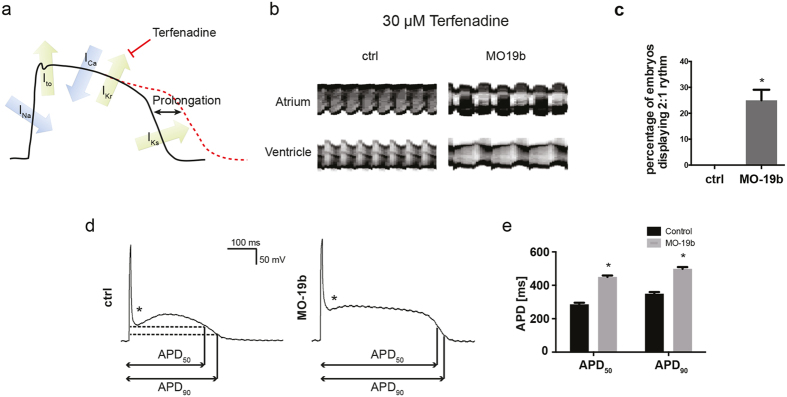
Loss of miR-19b induces prolongation of the action potential.(a) Schematic illustration of an action potential with major depolarizing and repolarizing currents depicted. Terfenadine inhibits IKr current, thereby prolonging the ventricular action potential. (b) Atrial and ventricular m-mode recorded from control and MO19b-injected Tg(Myl7:GFP) zebrafish embryos after 30 μM Terfenadine treatment. (b,c) 25% ± 4.1% of miR-19b deficient embryos develop an AV-Block with the ventricle skipping every other contraction, whereas control injected embryos show no phenotype. (±sd; n = 3 with ≥10 animals per group; p < 0.05) (d,e) Patch-clamp Experiments revealed that morpholino-mediated loss of miR-19b results in prolonged action potentials with up to 57% ± 3.8% and 39% ± 3.5% prolongation of APD50 and APD90, respectively (±sd; n ≥ 10 from 5 hearts; p < 0.05). Additionally, the notch appeared to be less pronounced (stars).